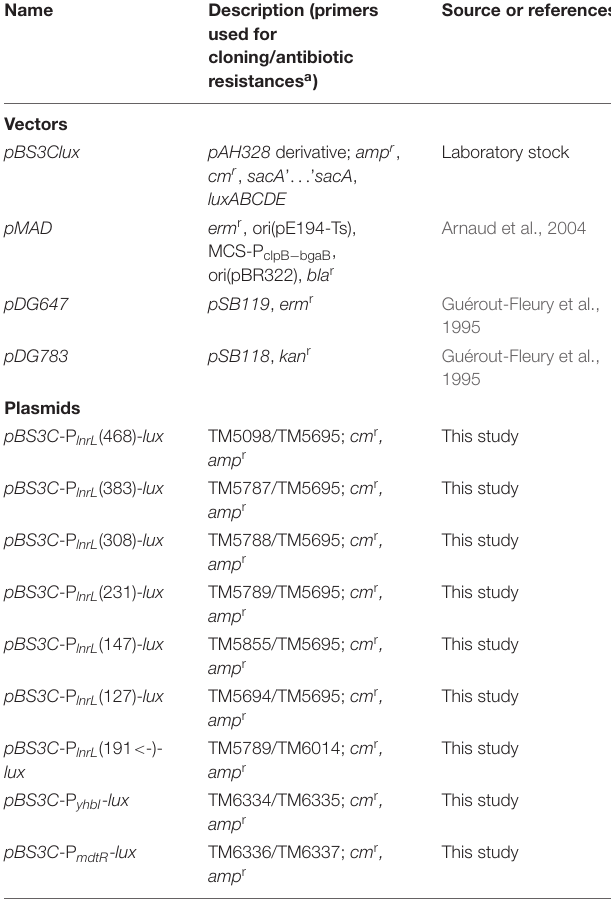
TABLE 2 | Vectors and plasmids used in this